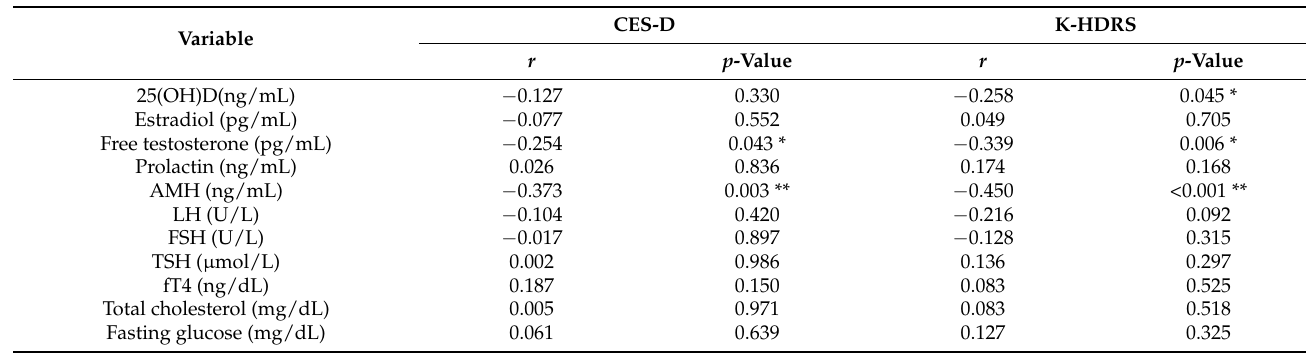
Table 2. Correlation between depression scores and biochemical variables after adjusting for age and body mass